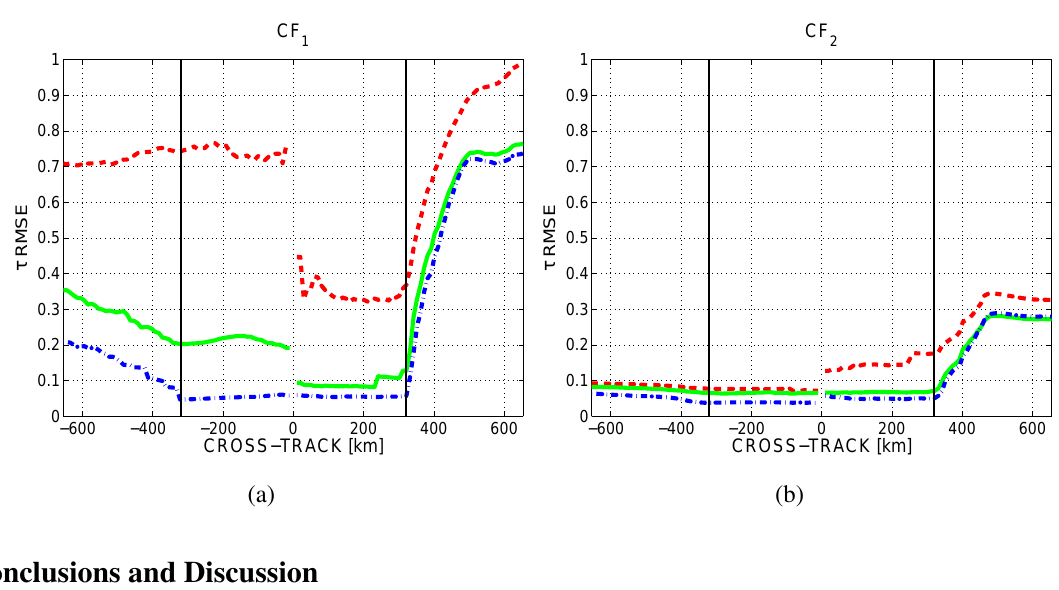
Figure 7. Retrieved vegetation opacity RMSE of simulated SMOS observations versus pixel position in the swath; Simulations over the vegetation-covered dry (red, dashed lines), moist(green, solid lines), and wet (blue, dashed-dotted lines) scenarios of Table 1, (a) with no constraints on the cost function ( CF ), and (b) adding constraints on all parameters, except s 1 ( CF ). In each plot: first Stokes parameter (left side) and Earth reference frame 2 (right side). Vertical lines denote the Narrow